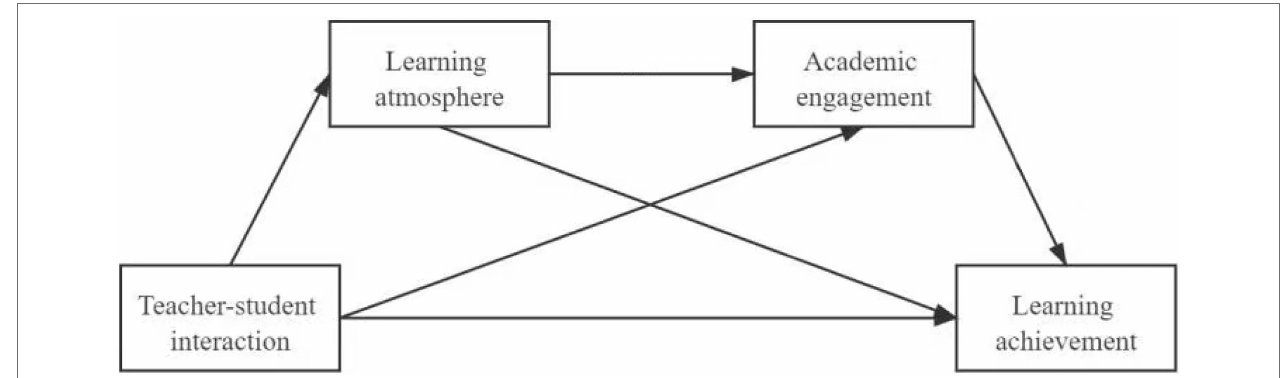
FIGURE 1 | Hypothetical model of the effect of teacher–student interaction on learning effect in online education.